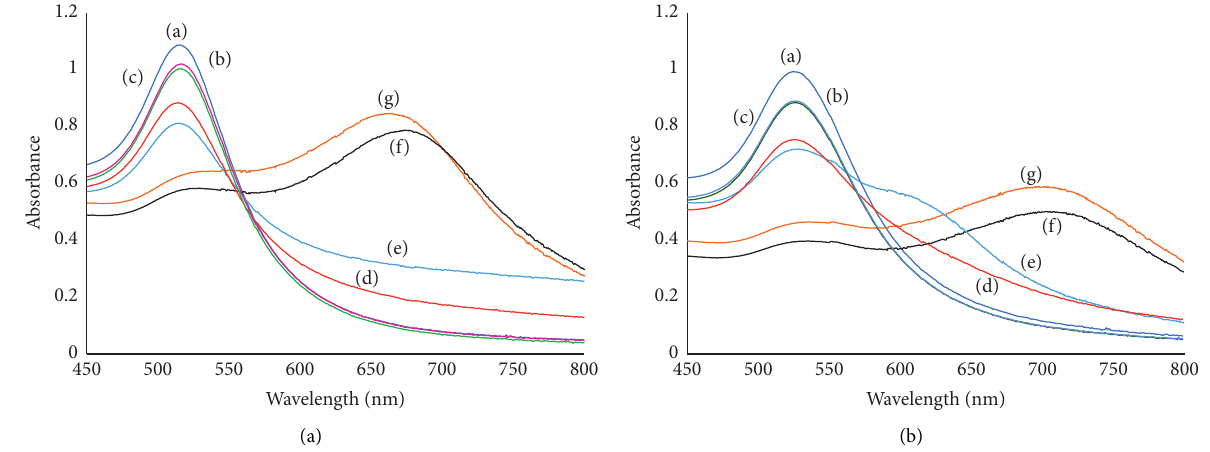
Figure 8: UV-Vis spectra of (i) Ac-Cit-HAuNPs and (ii) Ac-Cit-MAuNPs complexes after reacting with various concentrations ((a)